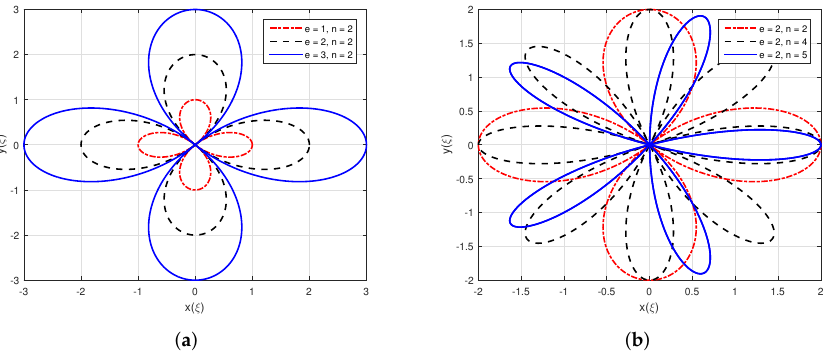
Figure 10. Rose spiral with various values of e and n : ( a ) rose spiral with constant n value and variable e and ( b ) rose spiral with constant e value and variable n